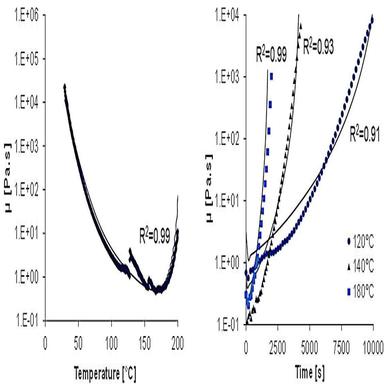
Viscosity under dynamic at 2 ◦C/min (left) and isothermal conditions (right) for modified epoxy RS-36-1. The model fit is shown with the solid line. (For interpretation of the references to colour in this figure legend, the reader is referred to the web version of this article.)